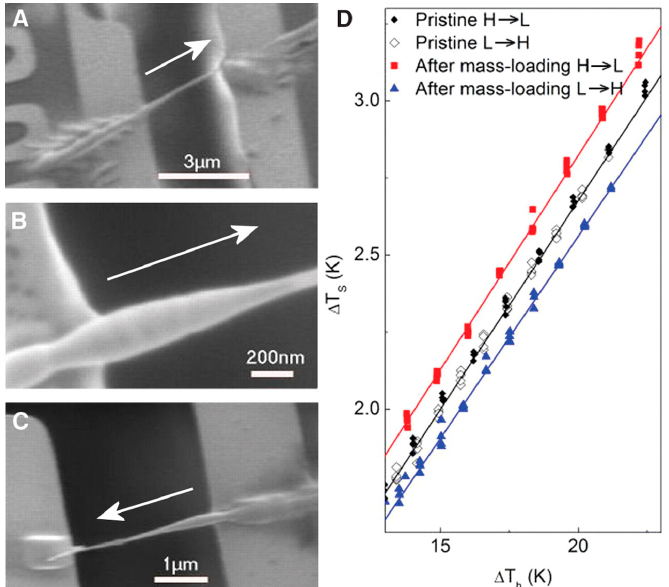
Figure 4. ( A – C ) SEM images of three different BNNTs after C9H16Pt deposition. ( D ) The temperature change of the sensor as a function of the temperature change of the heater before and after C9H16Pt deposition. Reprinted with permission from the American Association for the Advancement of Science.